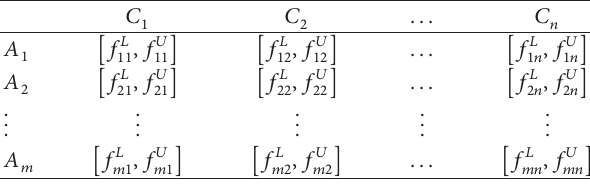
Table 2: Matrix format of a MADM problem with interval data. 𝐶 1